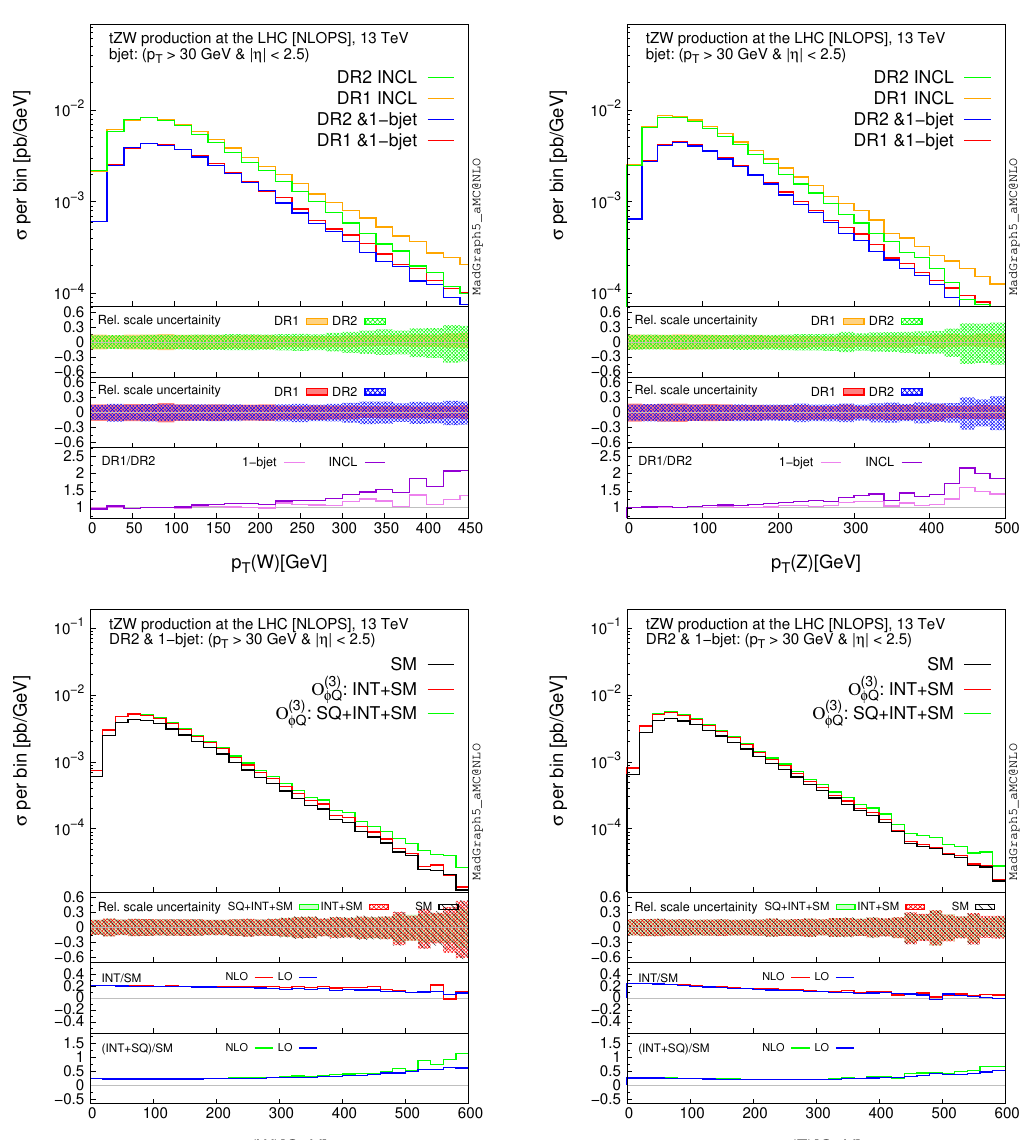
Figure 13 . The top row shows the NLOPS predictions for the transverse momentum of the W ± boson, p T ( W ) ( left ) and of the Z boson, p T ( Z ) ( right ) in the SM at DR1 and DR2 for both inclusive and 1-bjet scenarios. The insets in the top row are the same as in the left panel of figure 3. In all the predictions, only the t ¯ tZ overlap is removed as the Z boson is kept stable. The bottom row shows the same observables at DR2 for the O (3) SMEFT operator when the selection of one hard ϕQ b -jet is imposed, at NLOPS. The insets in the bottom row are the same as in figure